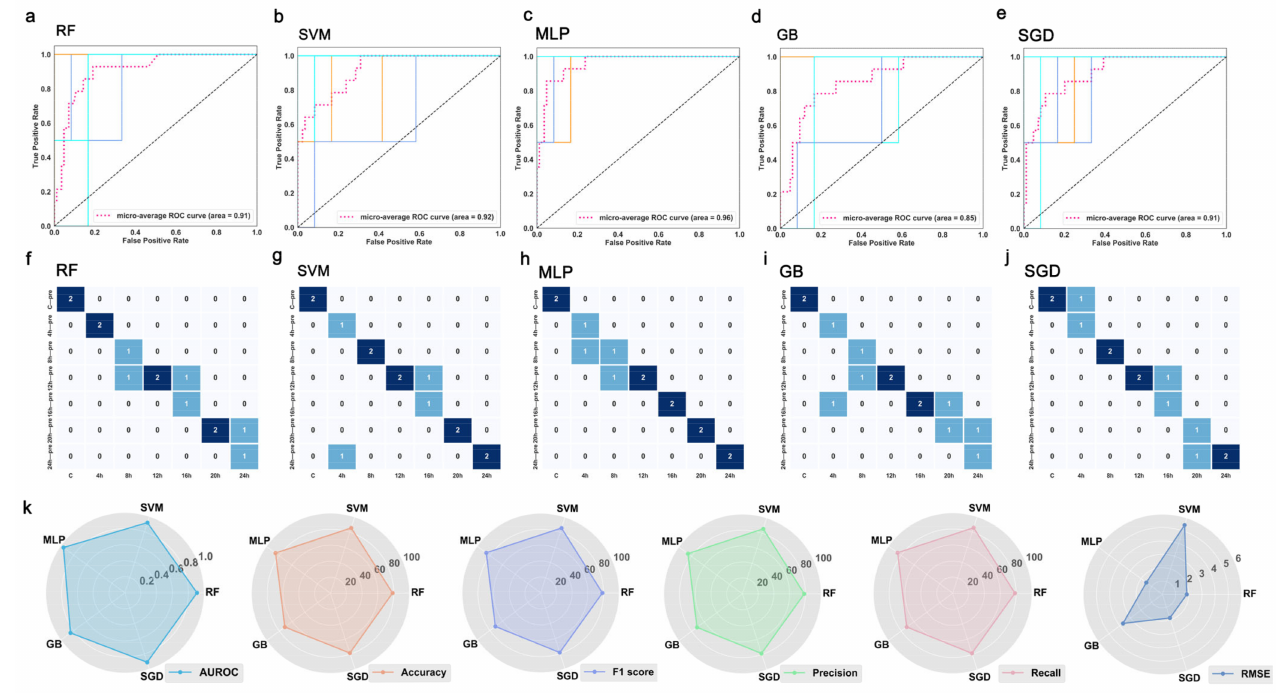
Figure 3. Predicted wound age against actual wound age for SVM, RF, MLP, GB, and SGD on the internal validation. The AUROC ( a – e ) and the confusion matrix ( f – j ) of five basic classifiers. The horizontal axis is the actual value, the vertical axis is the predicted value, and the diagonal line indicates that the prediction is correct. ( k ) Performance of five classifies on the internal